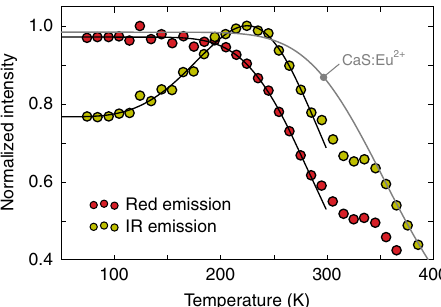
Fig. 4 Thermal quenching pro fi les. Thermal quenching curves for the red and infrared (IR) emission bands of CaS:Eu 0.01 Tb 0.01 , measured upon 470 nm excitation. The black curves are the result of fi tting Eqs. (1) and (2) for the red and IR emissions, respectively. The small shoulder ~340 K is likely due to thermoluminescence (TL) and is not explored further here. The gray curve shows the thermal quenching of singly doped CaS:Eu 0.01 for